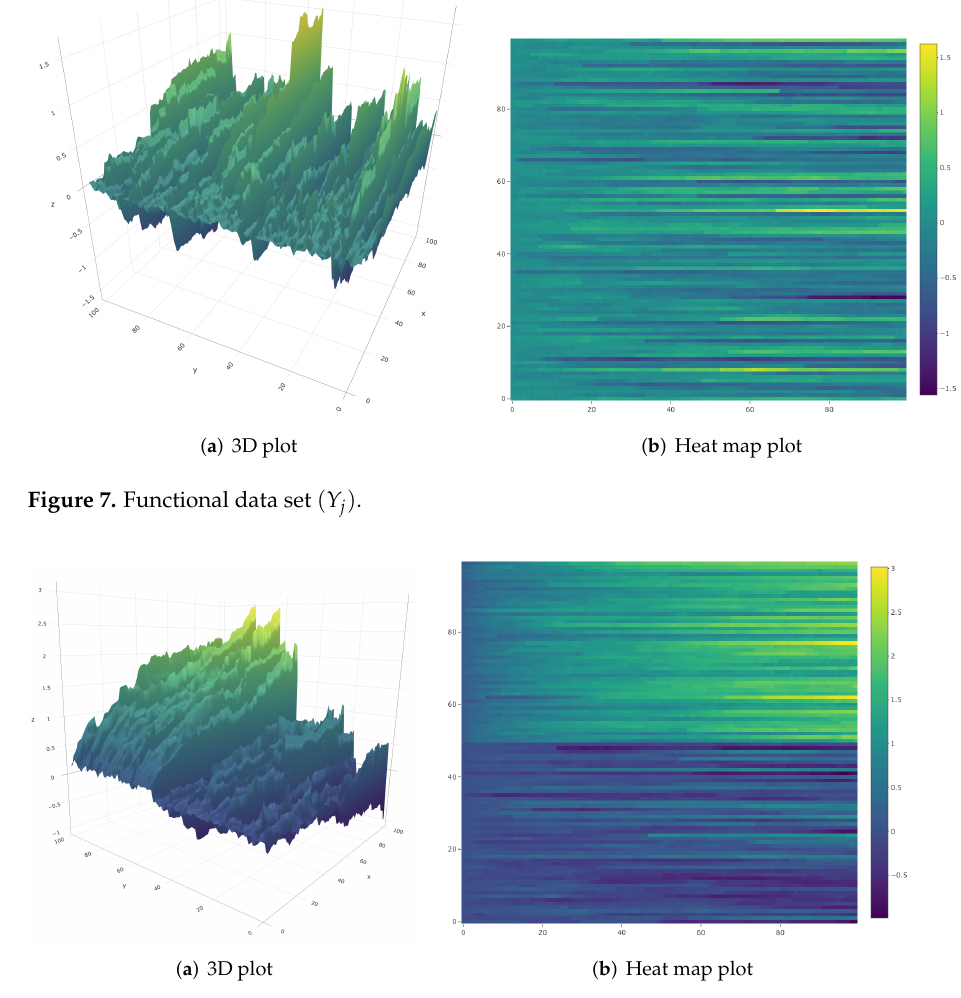
Figure 8. Functional sample ( X j ) with one